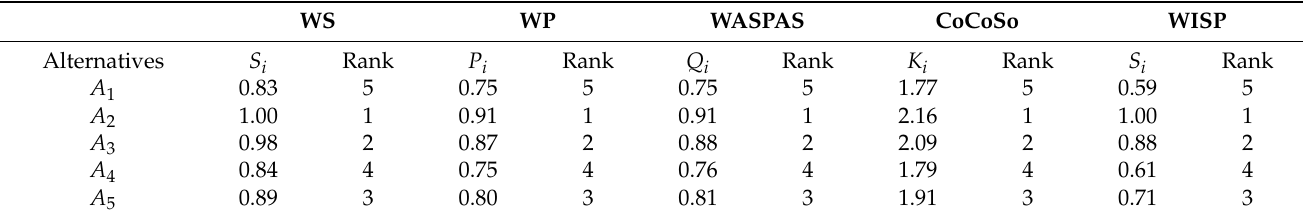
Table 12. Ranking of alternatives on the basis of 10 virtual respondents and crisp approach.